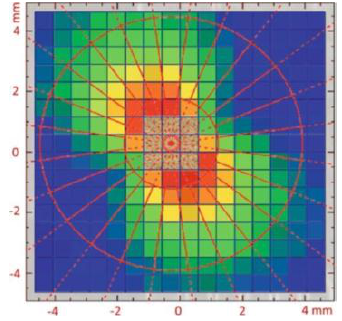
Figure 6. The false color scattering map with Caliste-256 for a 98% polarized 200 keV beam with the polarization plane 30° inclined with respect to the Caliste detector side axis. The red lines and circles show the the angular sectors and the double events hits distance range (adjacency order), respectively used to build the modulation curves presented in Figure 7.